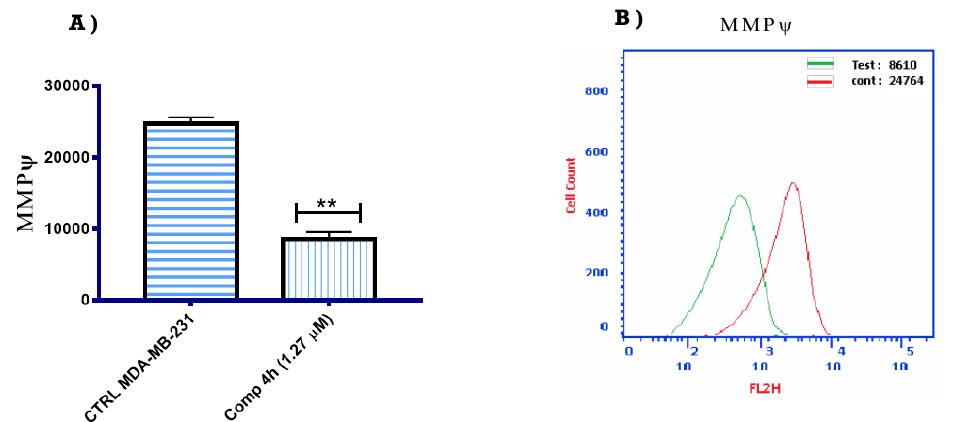
Figure 6. ( A ) Graphical representation for the effect of Schiff base 4h on the mitochondrial membrane potential in MDA-MB-231 cells after 24 h. ( B ) Effect of Schiff base 4h on the mitochondrial membrane potential in MDA-MB-231 cells after 24 h. All values are presented as mean value ± SD and statistical analyses were carried out using one-way analysis of variance (ANOVA) followed by Tukey’s multiple comparison test (** p < 0.01).